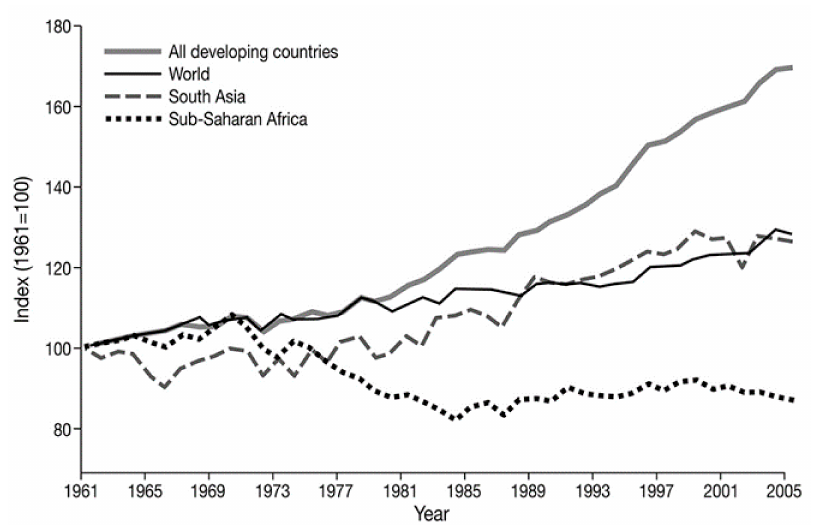
Figure 1. World agricultural production per capita 1961–2005 (index 1961 = 100)